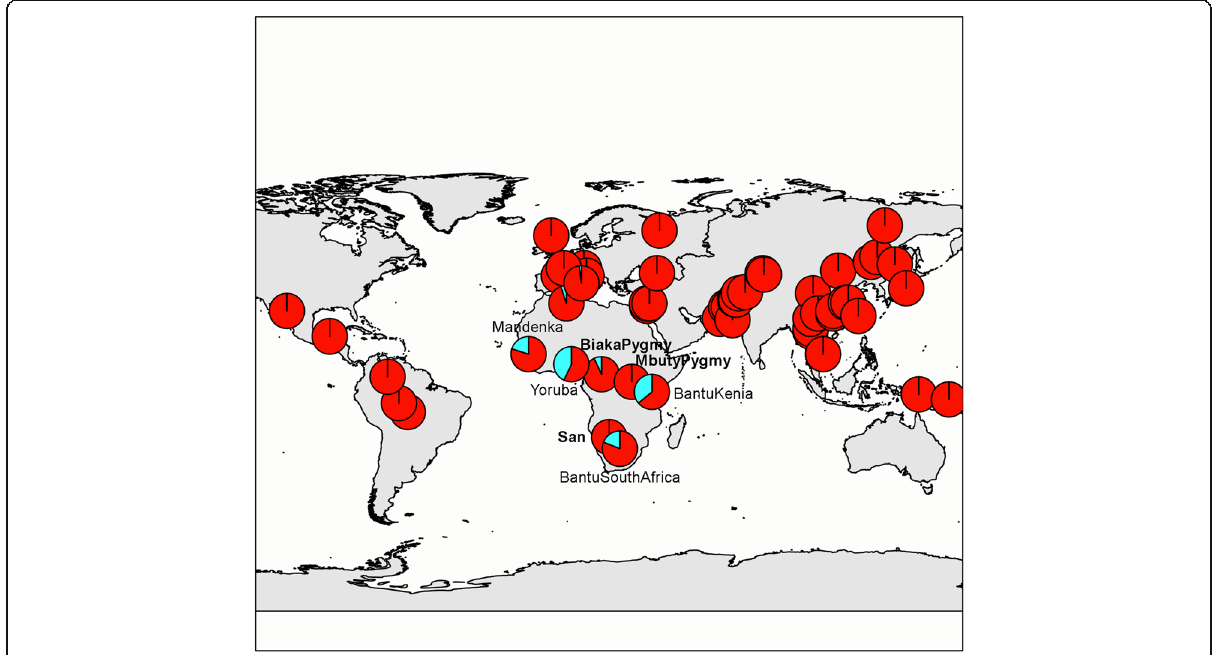
Fig. 3 Spatial frequency distribution of rs10485588 alleles. Each pie chart corresponds to one HGDP population and is positioned on the map according to the latitude and longitude data used by Rosenberg et al. [44]. Pie charts are colored according to the frequency of the common, ancestral A (red) and the derived G (light blue) alleles. Note that among the African populations, hunter-gatherers are written in